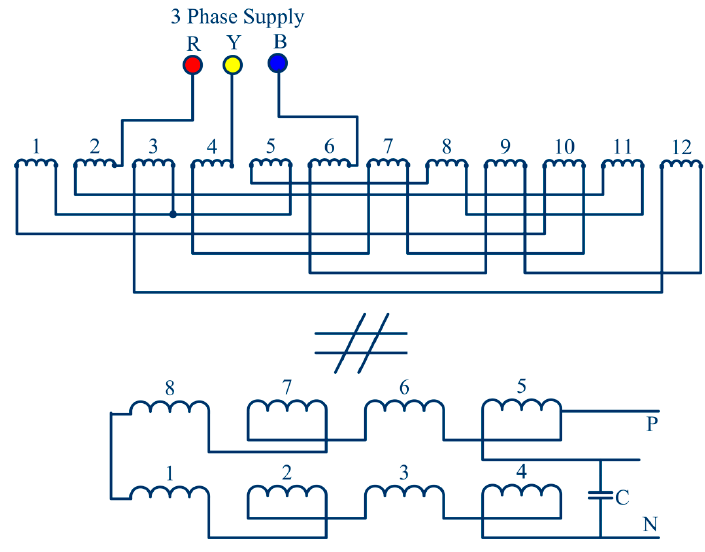
Figure 3. Proposed induction motor winding arrangement working as a phase converter.